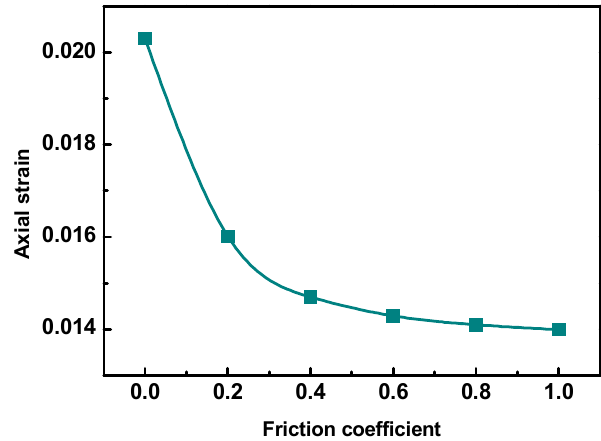
Figure 17. Axial strains with different aggregate surface textures.